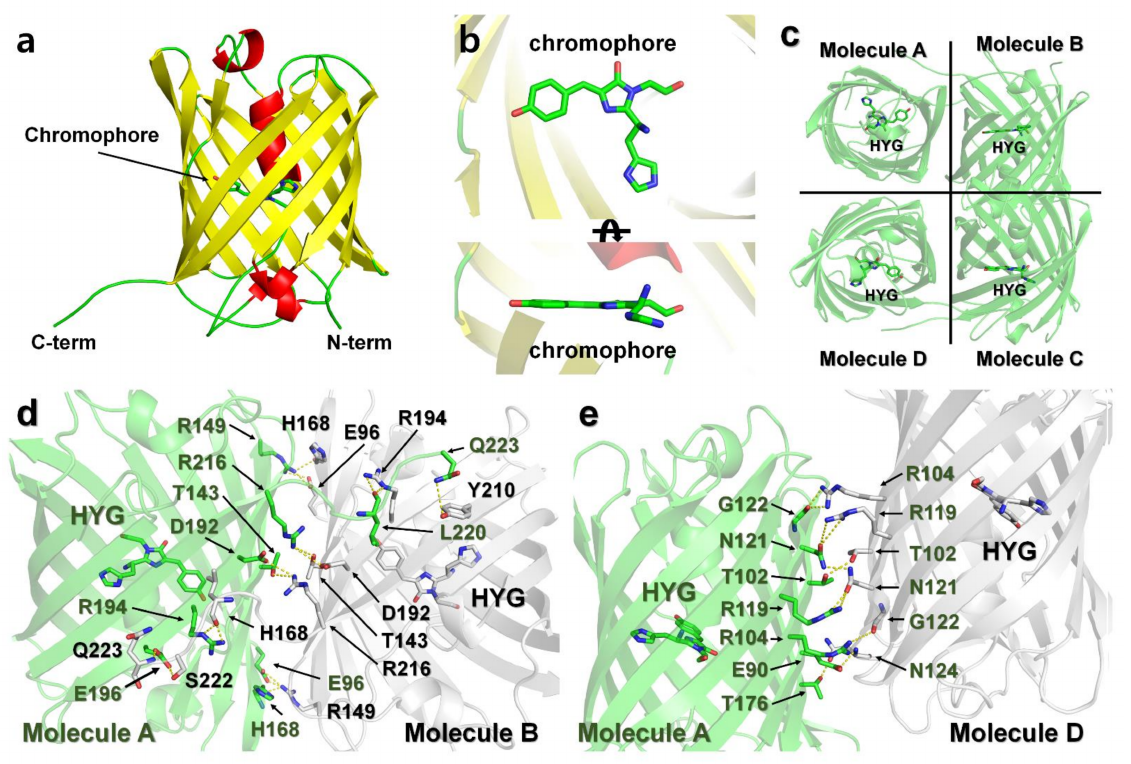
Figure 7. Crystal structure of DendFP. ( a ) Monomer structure of DendFP. ( b ) The chromophore of DendFP comprises the His62-Try63-Gly64 tripeptide (HYG). ( c ) Tetrameric structure of DendFP. Dimeric interface of molecules ( d ) A–B and ( e )